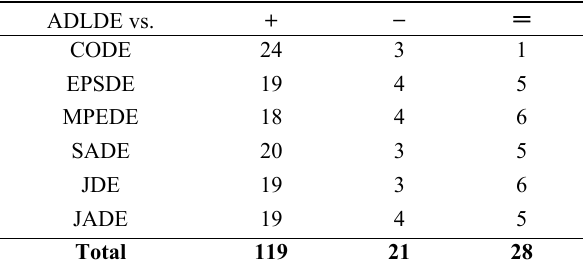
Table 5 Summary of function error values when D = 10. ADLDE vs.